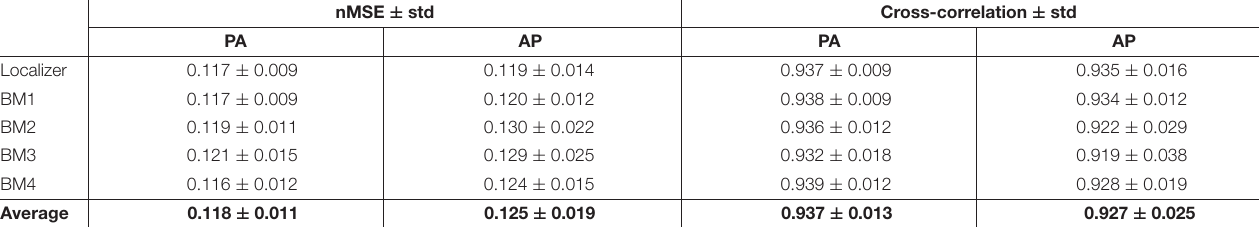
0.125 ± 0.019 0.937 ± 0.013 0.927 ±